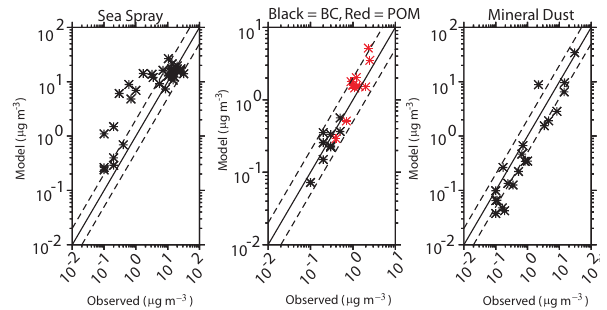
Fig. 8. Annual mean aerosol concentrations compared to the mea- surements. Measurements of sea salt are from IMPROVE and Uni- versity of Miami networks, dust from the university of Miami net- work and BC and POM from IMPROVE. Units are µgm − 3